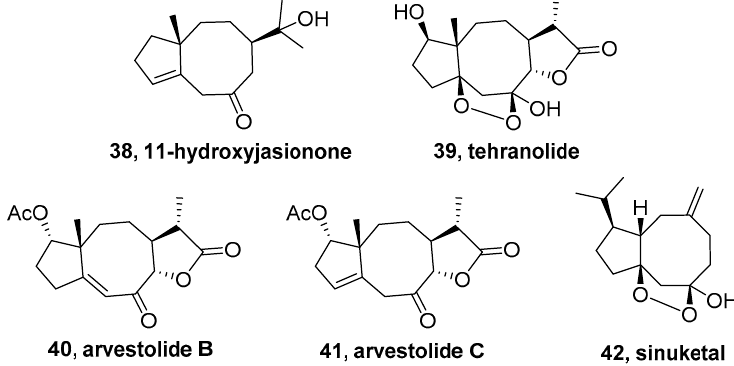
Figure 6. Structures of jasionane-sesquiterpenoids and sinularia-sesquiterpenoids.